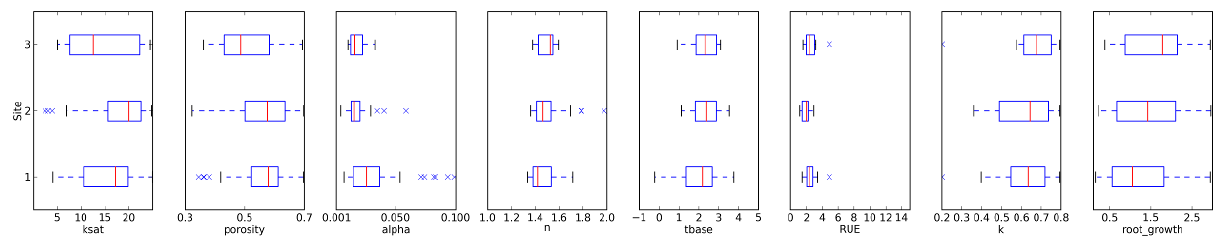
Fig. 4. Range of behavioural parameter sets considering all three threshold criteria of the CMF–PMF model for the three sites in Müncheberg. Results are shown for the same set of model input parameters as in Fig. 1.